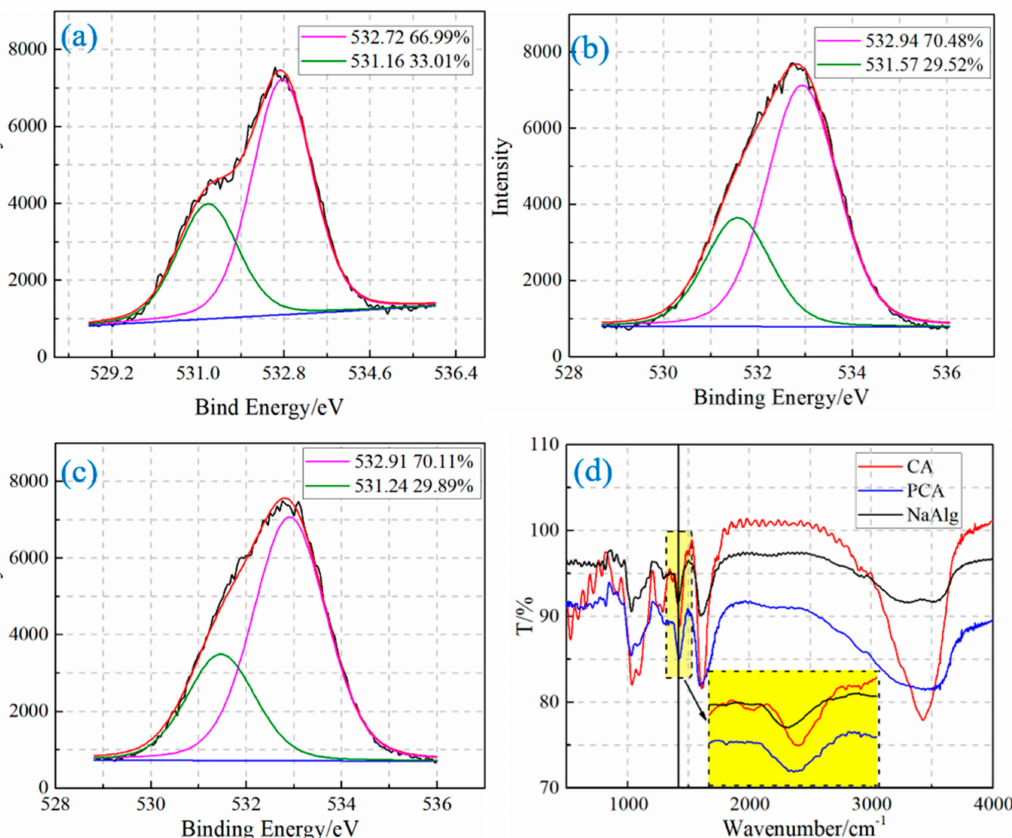
Figure 4. The results of XPS and FTIR: ( a ) the peaks splitting and fitting of O1s high-definition spectrogram of sodium alginate, ( b ) the peaks splitting and fitting of O1s high-definition spectrogram of CA, ( c ) the peaks splitting and fitting of O1s high-definition spectrogram of PCA, ( d ) the FTIRs of PCA, CA, and sodium alginate. Note: In Figure 4a–c, the black line represents the original data, the red line represents the curve after fitting, and the pink and green lines are the curves after peaking according to the fitted